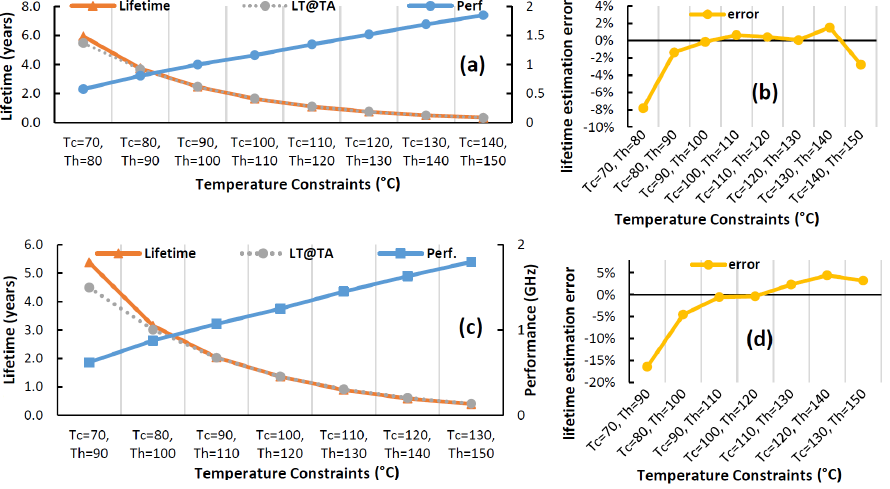
Figure 14. Performance–lifetime trade-off exploration: ( a ) T c = 80 ◦ C, T h = 100 ◦ C; ( b ) T c = 80 ◦ C, T h = 100 ◦ C zoom-in; ( c ) T c = 70 ◦ C, T h = 110 ◦ C ( d ) T c = 70 ◦ C, T h = 110 ◦ C